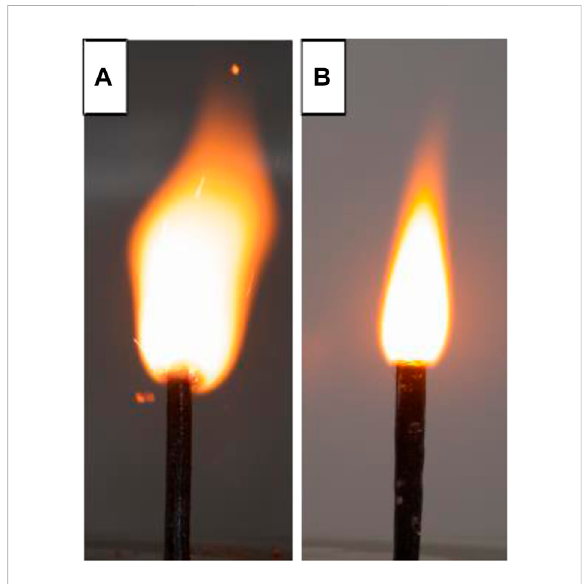
FIGURE 8 (A) Blank propellant; (B) Propellant formula containing K 2 Pb [Cu(NO 2 ) 6 ] (Xia et al.,